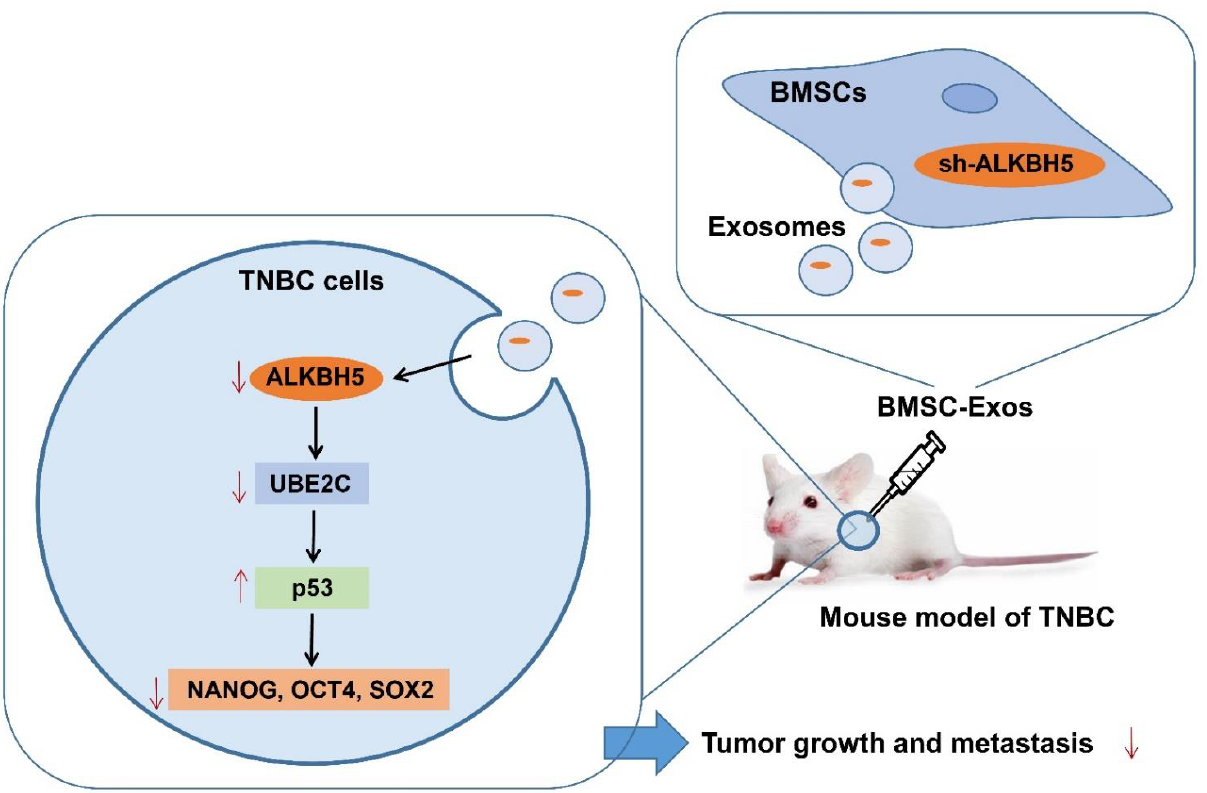
Figure 8. Schematic diagram of the mechanism by which BMSC-Exos affect the growth and metastasis of TNBC. ALKBH5 may promote TNBC cells to acquire stemness by mediating the UBE2C/p53 axis, thereby promoting TNBC growth and metastasis. ALKBH5 shRNA-loaded BMSC-Exos significantly inhibits the growth and metastasis of TNBC.